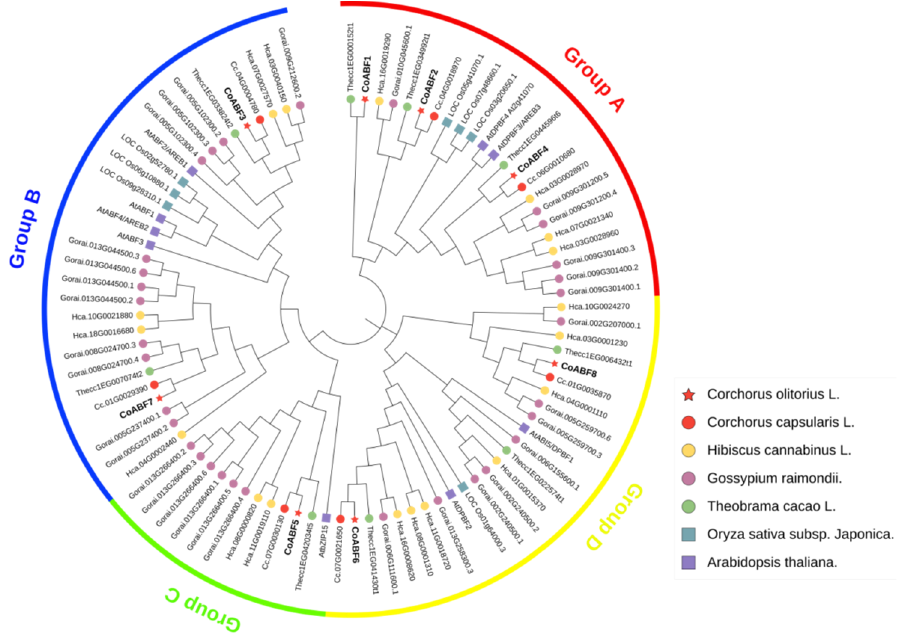
Figure 1. Phylogenetic analysis and family classification of the AREB/ABF proteins were analyzed. The different colored arcs indicate the diverse groups of the AREB/ABF proteins. Protein sequences from jute ( C. olitorius and C. capsularis ), kenaf ( H. cannabinus ), cotton ( G. raimondii ), cacao ( T. cacao ), rice ( O. sativa ), and Arabidopsis are indicated by red stars, red, yellow, purple, and green circles, and blue and purple squares, respectively.